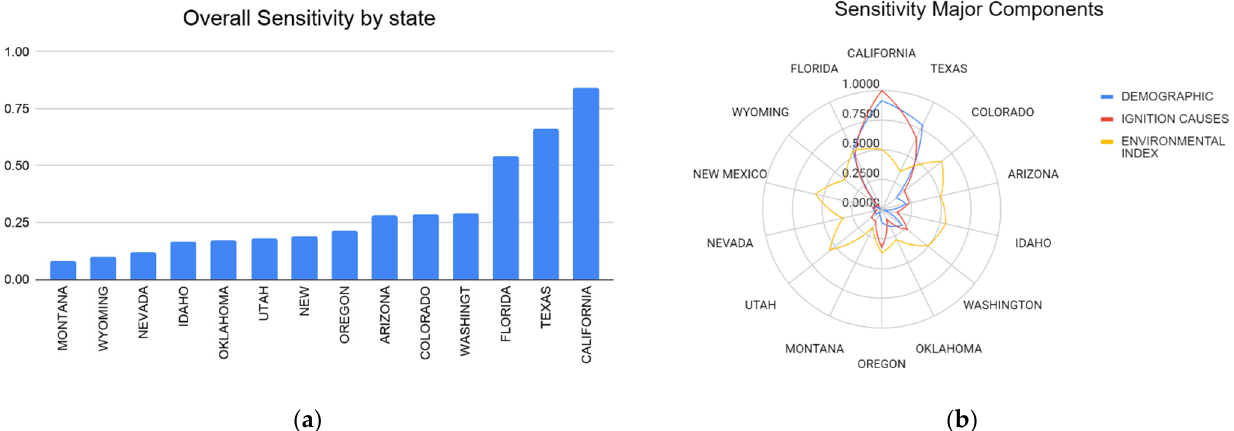
Figure 6. Histogram showing the overall sensitivity of the 14 selected states in the US with California having the highest sensitivity (with respect to wildland fire) and Texas having the lowest overall sensitivity ( a ). Radar plot showing the different major components of the sensitivity contributing factor, namely, demographic (blue), ignition causes (red), and the environmental index (yellow) for the selected 14 states of the US used in this study ( b ).